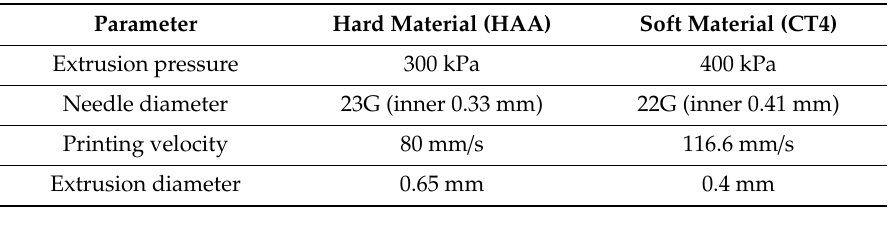
Table 2. Printing parameters of multi-materials pads.